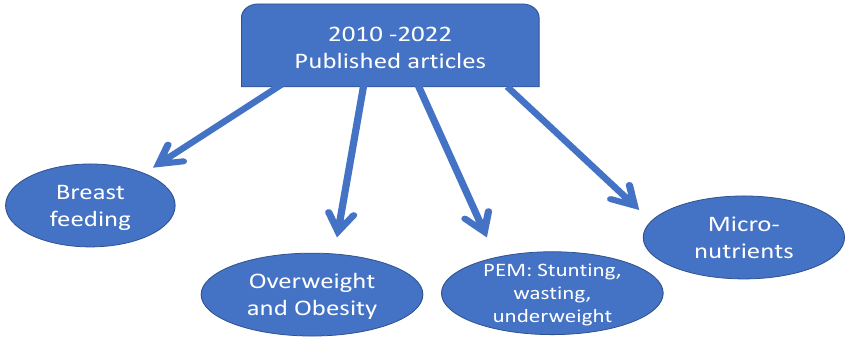
Figure 1. Literature review main themes.